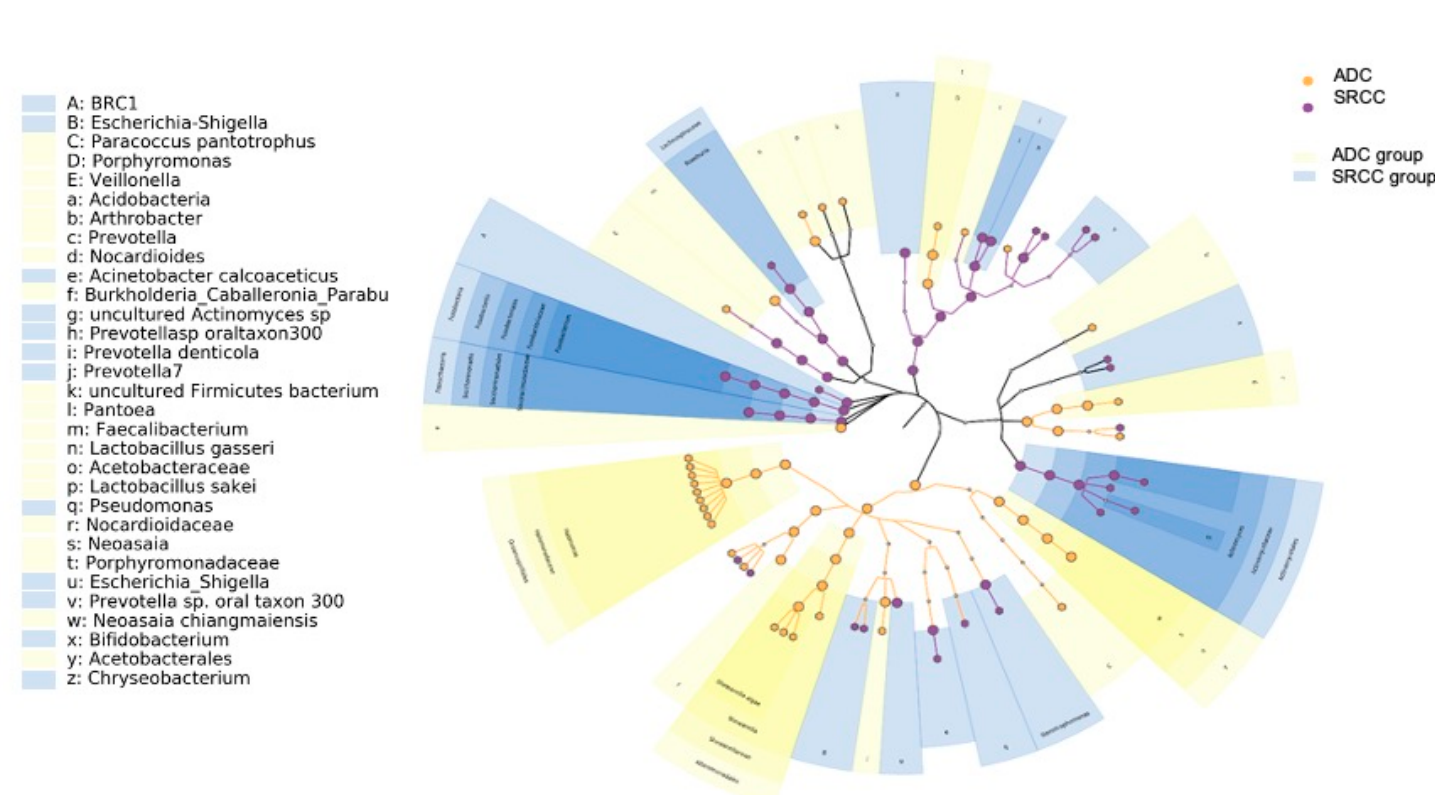
Figure 3. ( A ) LEfSe (linear discriminant analysis coupled with e ff ect size) identified the most di ff erentially abundant taxa between ADC, ADC PNT (paired non-tumor), SRCC and SRCC PNT. Only taxa meeting an LDA (linear discriminant analysis) significant threshold of > 2 are shown. ( B ) Taxonomic cladogram obtained from LEfSe analysis of 16S sequences. In particular, two shapes are used to plot the nodes: circle and hexagon, corresponding to taxonomic and ASV clades, respectively. The node bodies are filled if associated to one specific condition following the LEfSe analysis. Moreover, the nodes background is imposed if all the child nodes belong to the same macro-group (i.e., ADC group and SRCC group correspond to tumor and healthy tissues collected from ADC and SRCC subjects, respectively). Unannotated clades correspond to ambiguous taxa in the reference taxonomy (i.e., SILVA).